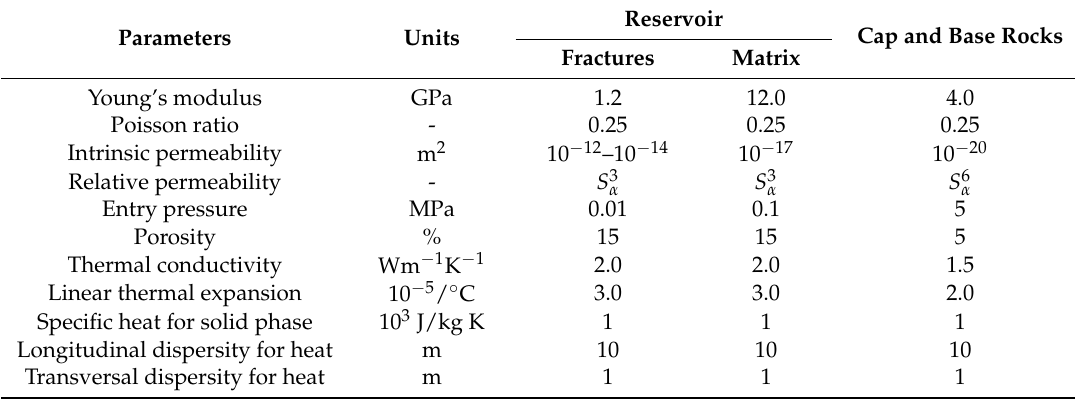
Table 1. Material properties used in the thermo-hydro-mechanical analysis of the naturally fractured reservoirs